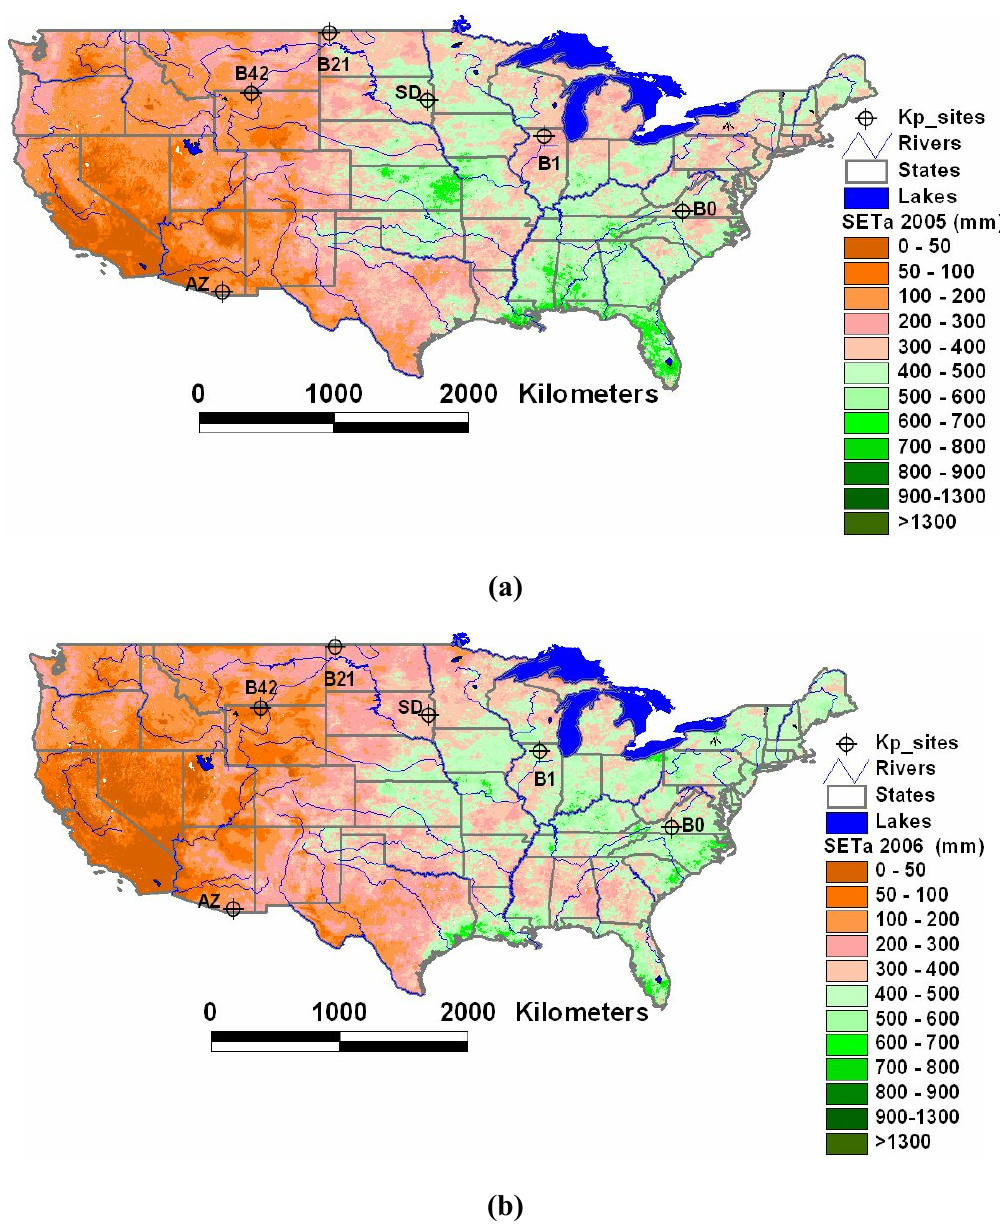
Figure 4. Seasonal VegETa ETa (May–September) maps for 2005 (a) and 2006 (b) . Kp_sites refer to locations where the Kcp (B1 – B42) and AmerixFlux (SD, AZ) latent flux data were